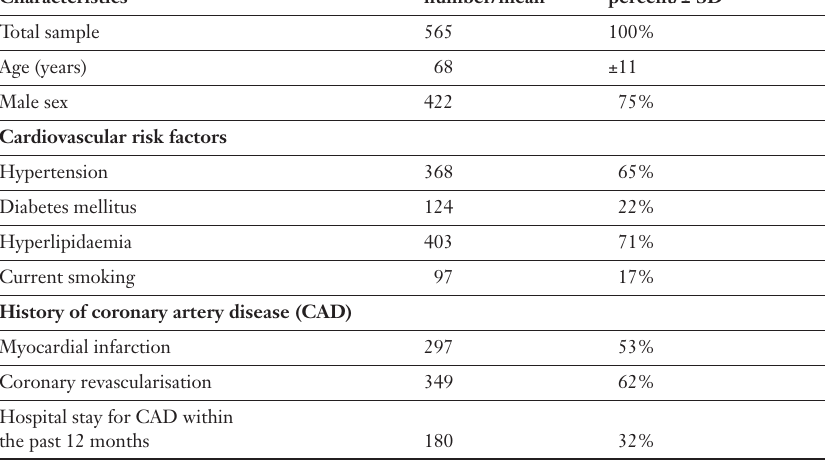
Patient characteris- tics of the study